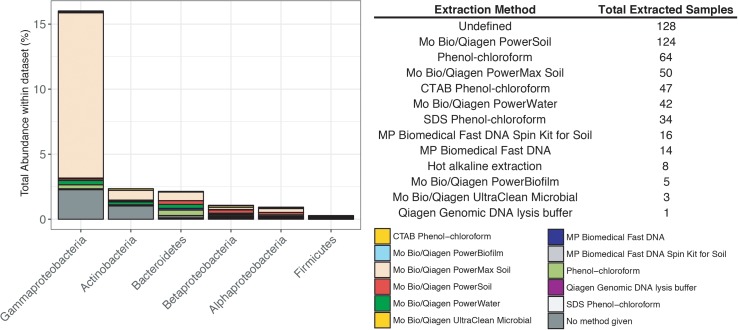
Influence of DNA extraction method on the total abundance of contaminants encountered in the CoDL dataset. The table records the type of DNA extraction method and the total number of samples extracted with that method.